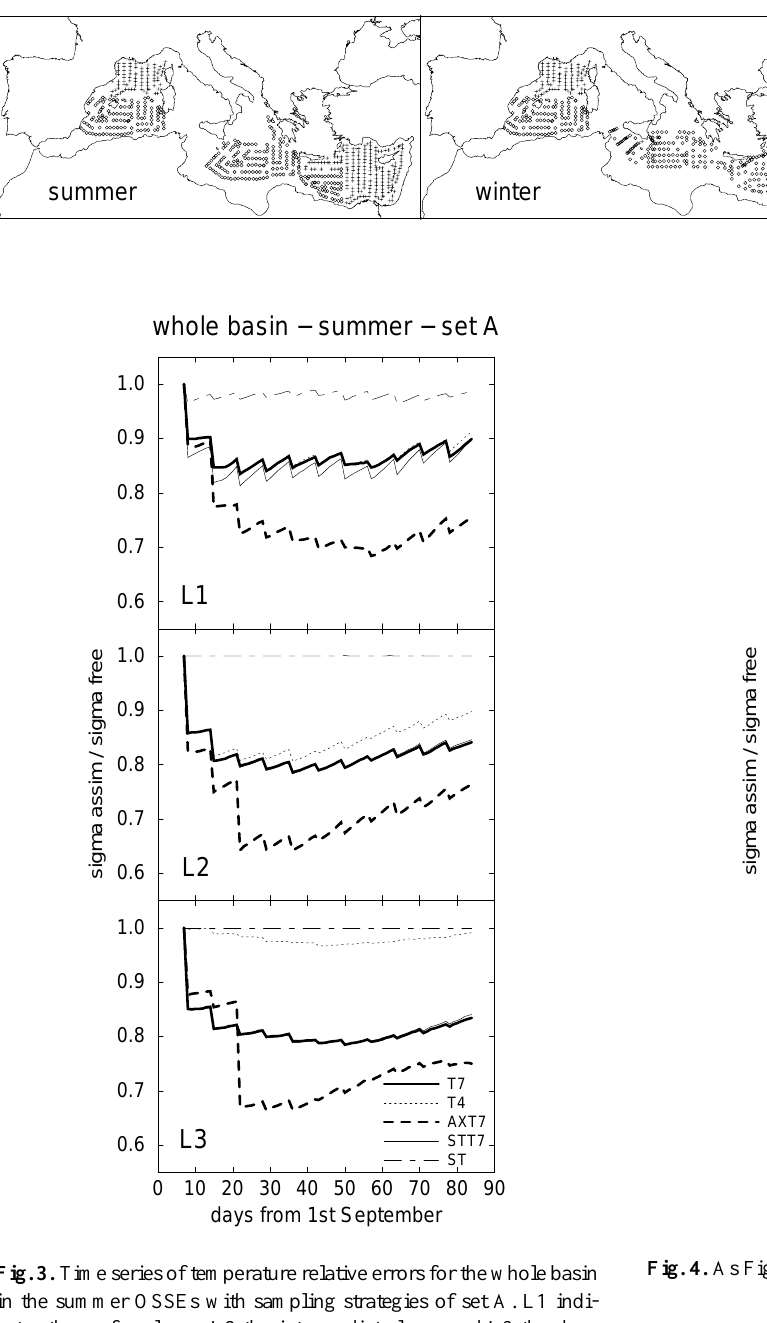
Fig. 3. Time series of temperature relative errors for the whole basin in the summer OSSEs with sampling strategies of set A. L1 indi- cates the surface layer, L2 the intermediate layer and L3 the deep layer.